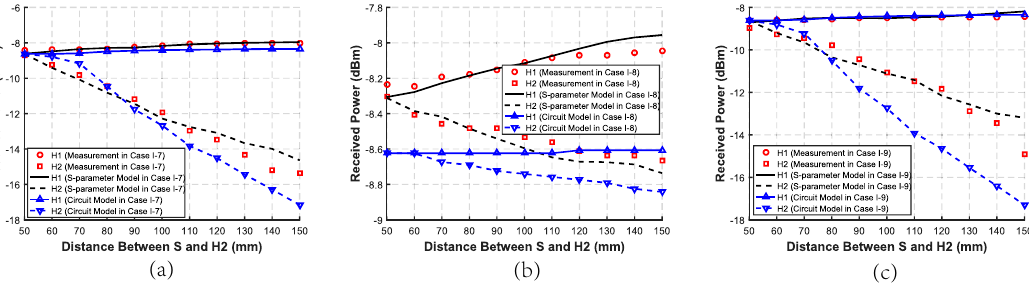
Figure 11. Measurement, simulated S-parameter model, and circuit model received power of two harvesters with different distances between S and H2 in the SSMH-OP case. ( a ) Case I-7 with only backward distance changing. ( b ) Case I-8 with only forward distance changing. ( c ) Case I-9 with forward and backward distances remaining the